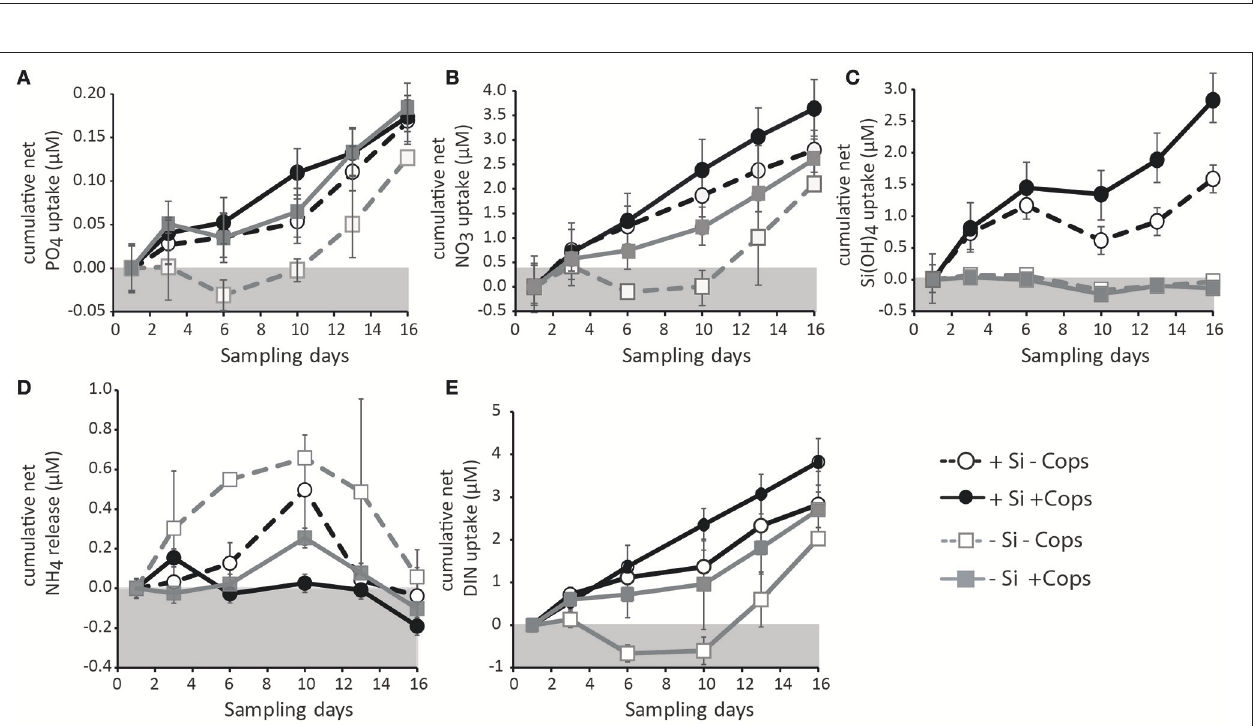
FIGURE 4 | Cumulative net uptake in the different mesocosm treatments of (A) phosphate, (B) nitrate, (C) silicate, and (E) total DIN. (D) show the cumulative net regeneration of ammonium. Data points and error bars represent averages and standard deviations for the three mesocosms of each treatment.